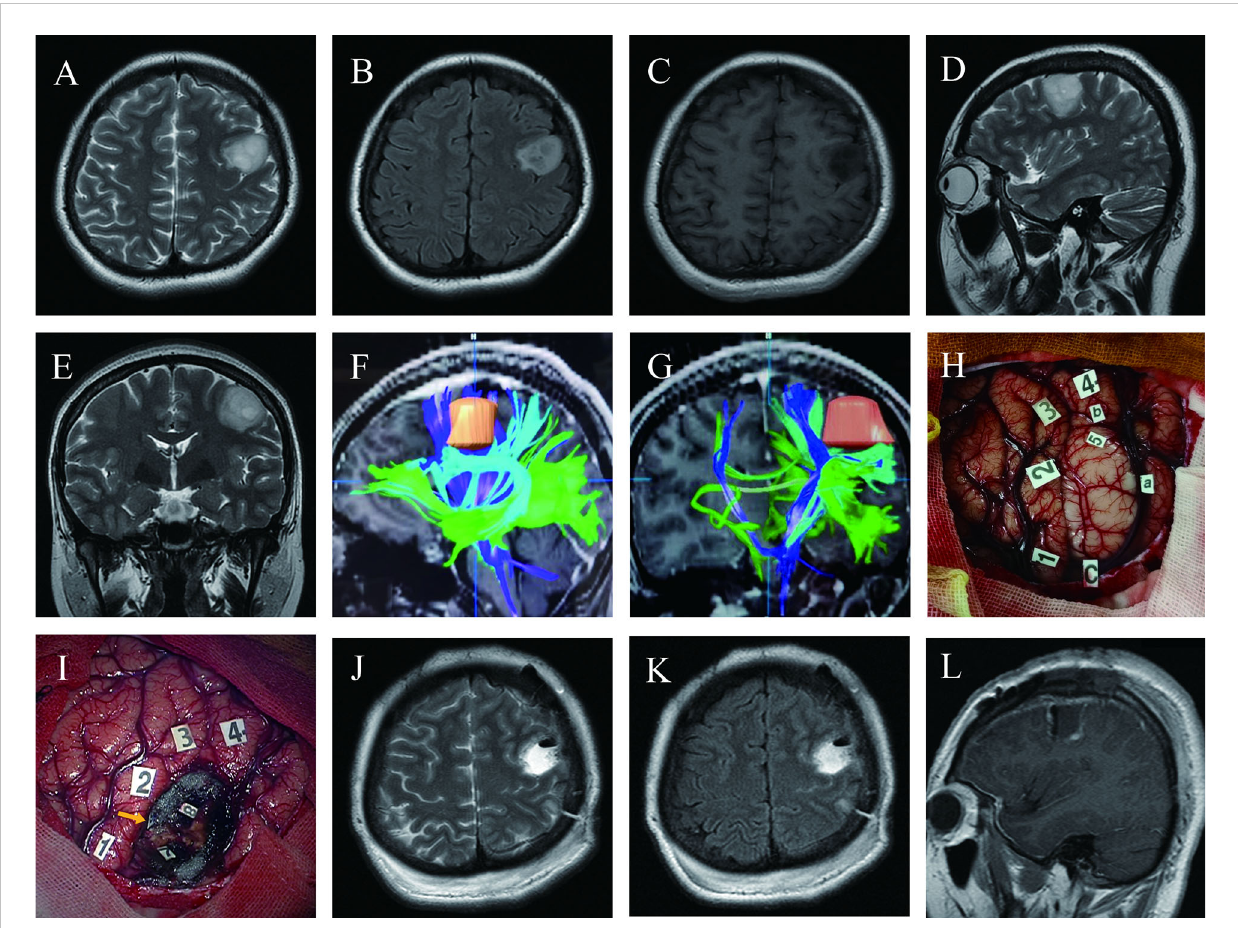
FIGURE 1 Maximum safe resection of oligodendroglioma harboring IDH mutation and 1P/19Q codeletion (WHO Grade 3) in the inferior left precentral gyrus under awake craniotomy in a 27-year-old woman presenting with seizures (Case 9); (A – E) Pre-operative T2 axial, T2 FLAIR axial, T1-weighted gadolinium- enhanced axial, T2 sagittal, and T2 coronal MRI revealed the tumor ’ s location precisely in the inferior lateral left hand knob of the precentral gyrus. (F, G) DTI-based reconstructed fi bers showed arcuate fasciculus beneath the lesion and slightly distorted, and the pyramidal tract was medial to the lesion; (H) Intraoperative view before tumor resection; Tumor borders marked by letters (a, anterior; b, superior; c, inferior). Number of tags denotes positive DES mappings (1, paresthesia of the right little and ring fi ngers; 2, numbness of the right thumb; 3, paresthesia of the right corner of mouth; 4, motor responses in the right corner of mouth; tag 5 is on the surface of the tumor, where speech arrest and convulsions of the right corner of the mouth were induced during DES); (I) Intraoperative view after tumor resection based on the functional boundary; The tumor was removed until DES mapping encountered eloquent brain areas at cortical and subcortical levels (Tag 7, movement of the right hand during DES; 8, movement of the right corner of the mouth; 9 with a yellow arrow, an electrifying sensation of the right index fi nger); (J – L) Twenty-four hours postoperative T2 axial, T2 FLAIR axial, and T1-weighted gadolinium-enhanced sagittal MRI demonstrated total tumor